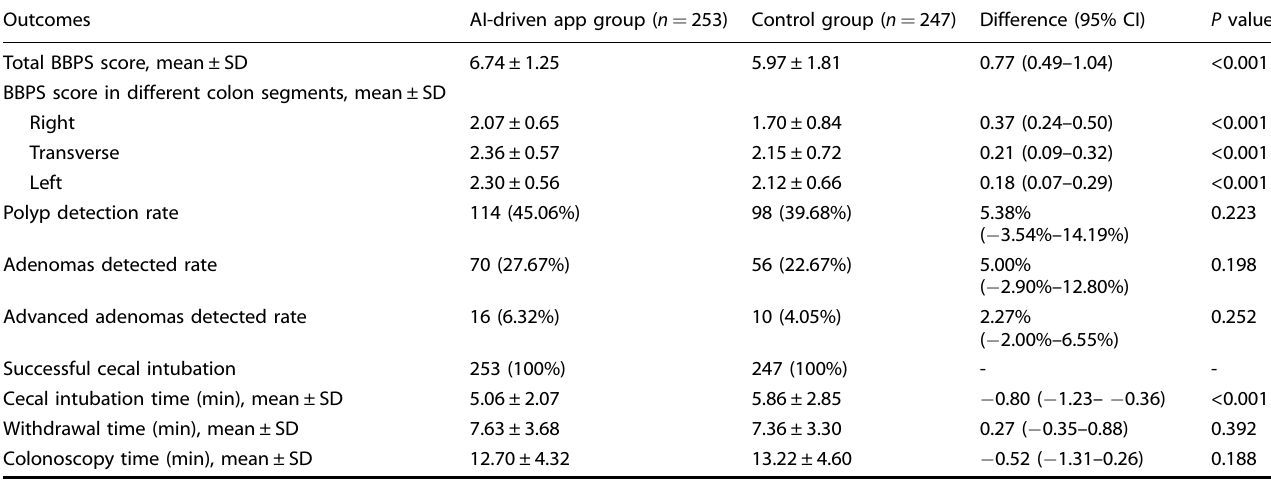
Table 3. Effect of AI-driven app on the outcome of bowel preparation and